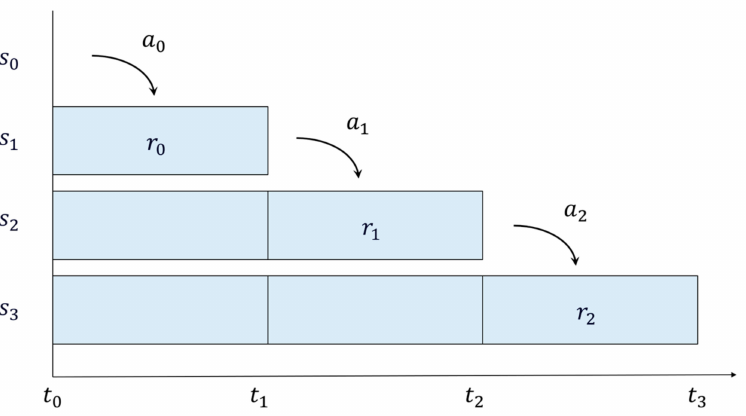
Figure 5. Concept of reward